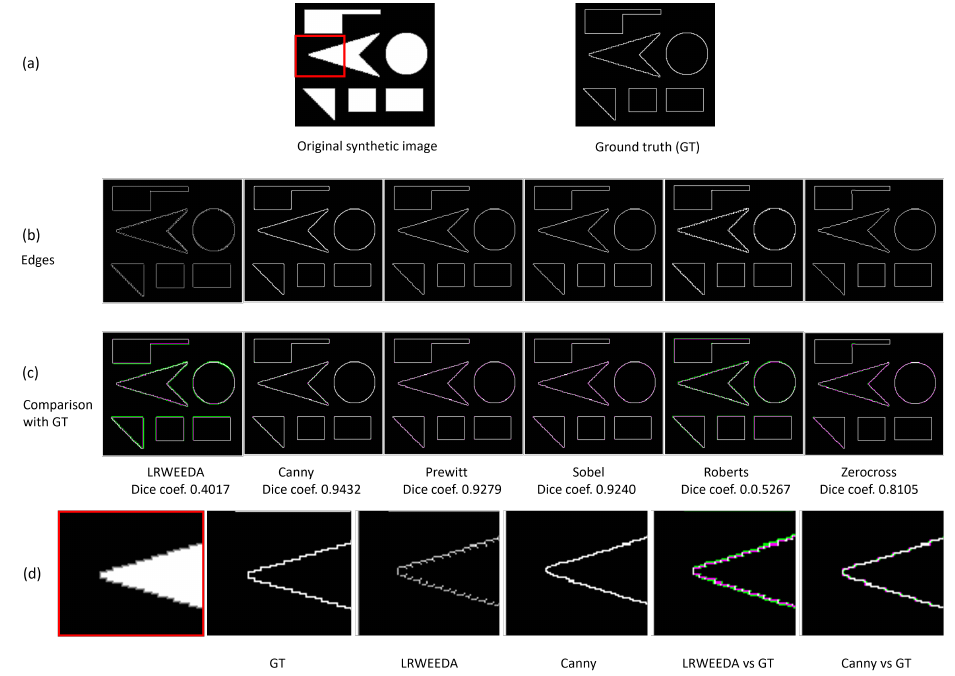
Figure 12. A synthetic image was used to calculate the Dice coefficient of the proposed algorithm. The original synthetic image (270 × 238 pixels) and the ground truth edges (270 × 238 pixels) are shown in ( a ). The edges obtained by LRWEEDA, Canny, Prewitt, Sobel, Roberts and Zero cross algorithms are shown from left to right in ( b ). In ( b ), all the images are 270 × 238 pixels. The edges were compared with the ground truth in ( c ). The edges calculated by each algorithm and the ground truth edges are shown in green and purple, respectively. The overlap between the calculated edges and the ground truth is shown in white. The Dice coefficient for each algorithm is shown under each image. The red color box in ( a ) is enlarged for the analysis purpose in ( d